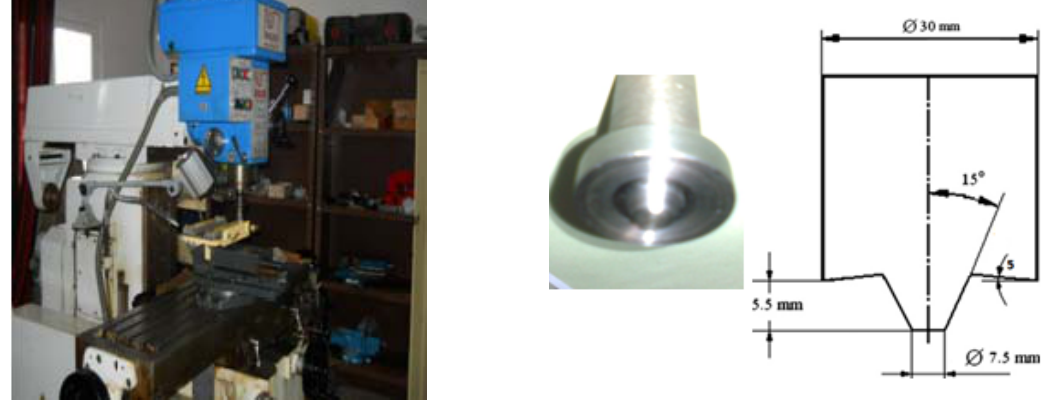
Figure 3: milling machine Figure 4: FSW welding